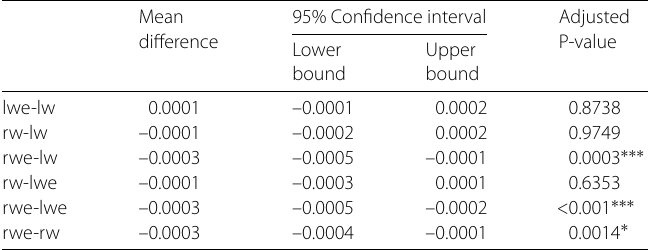
Table 13 Multi-group mean comparisons of fairness using Tukey’s HSD test Mean 95% Confidence interval difference